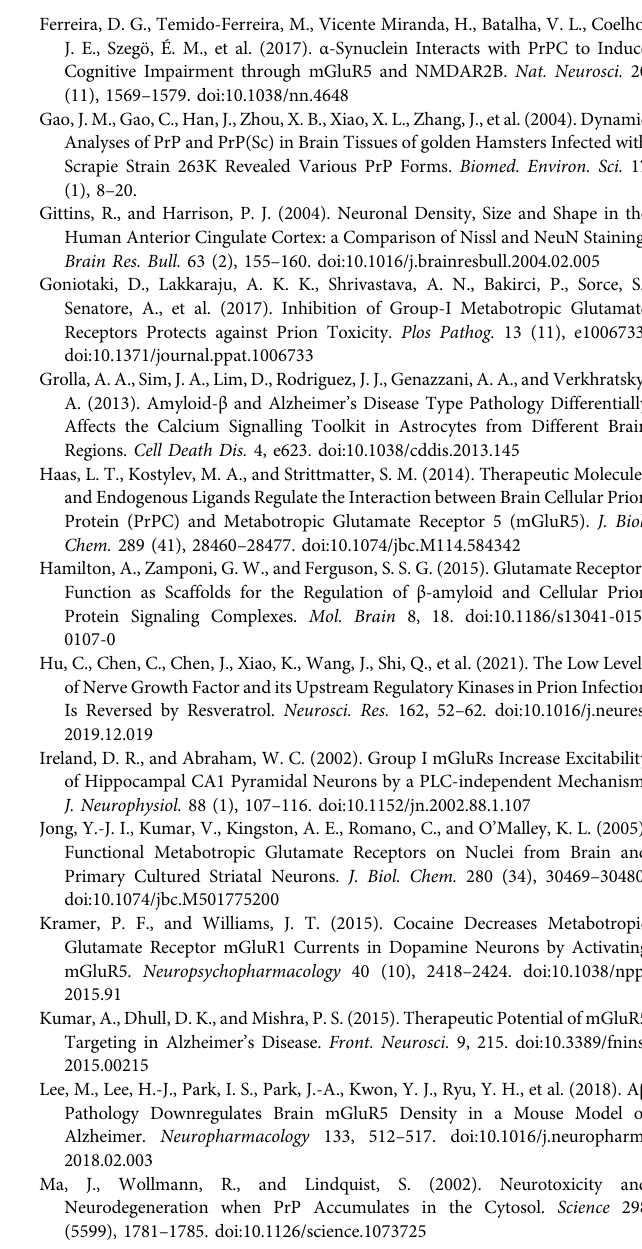
Supplementary Figure S1 | The level ofmGluR1 in SMB-PS and -S15 cells as well as CHPG treated SMB-PS cells. (A) Left : Western blot for the levels of mGluR1 in SMB-PS and SMB-S15. Relative molecular weights are marked on the left. Right : Densitometric analyses of the average gray values of the signals of the mGluR1 after being equilibratedwith thatof β -actin. (B) Left : Western blotfor the levels ofmGluR1 in CHPG treated SMB-PS cells. Right : Densitometric analyses of the average gray values of the signals of the mGluR1 after being equilibrated with that of β -actin. Supplementary Figure S2 | The level of mGluR1 in brains of 263K-infected hamster at end stage. (A) Upper : Western blot for the levels of brain mGluR1 in control and Ha-263K. Relative molecular weights are marked on the left. Lower : Densitometric analyses of the average gray values of the signals of the mGluR1 after being equilibrated with that of β -actin. (B) Immuno fl uorescent staining of mGluR1 in cortex, cerebellum and hippocampus regions of 263K-infected hamsters. The